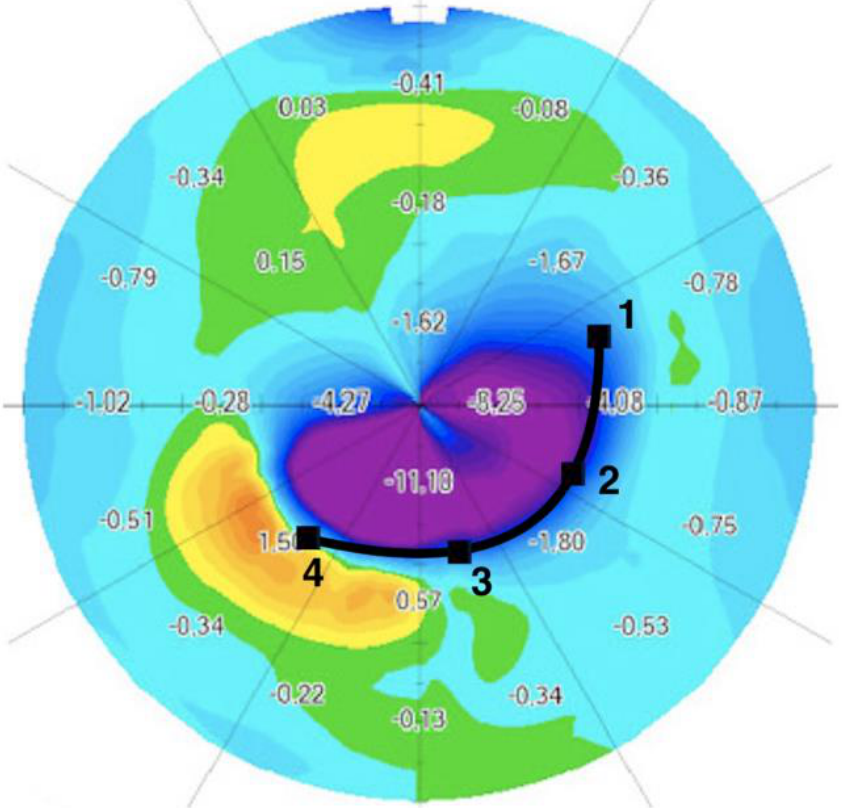
Figure 2. Keratometry variation after AJL PRO + ICRS implantation to treat duck-type keratoconus. The ICRS is split into sections defined by 4 equidistant points, from the thinnest part (point 1) to the widest (point 4). For each point, we calculated the change in anterior sagittal keratometry in diopters. The MS39 system locates the apex of the cone. The pachymetry and epithelial thickness at the apex of the cone and its distance from the center of the cornea were measured before and six months after ICRS